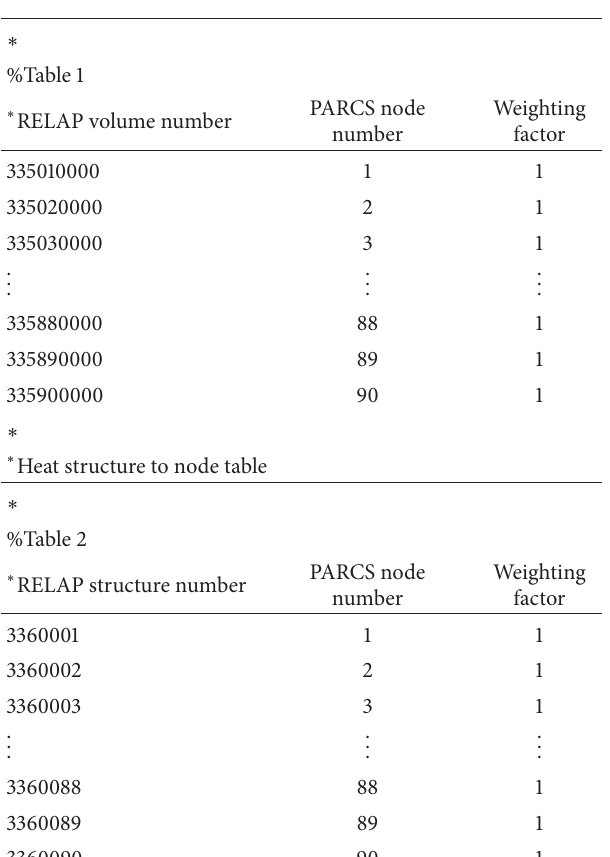
Table 1: PARCS/RELAP5 mapping input file.